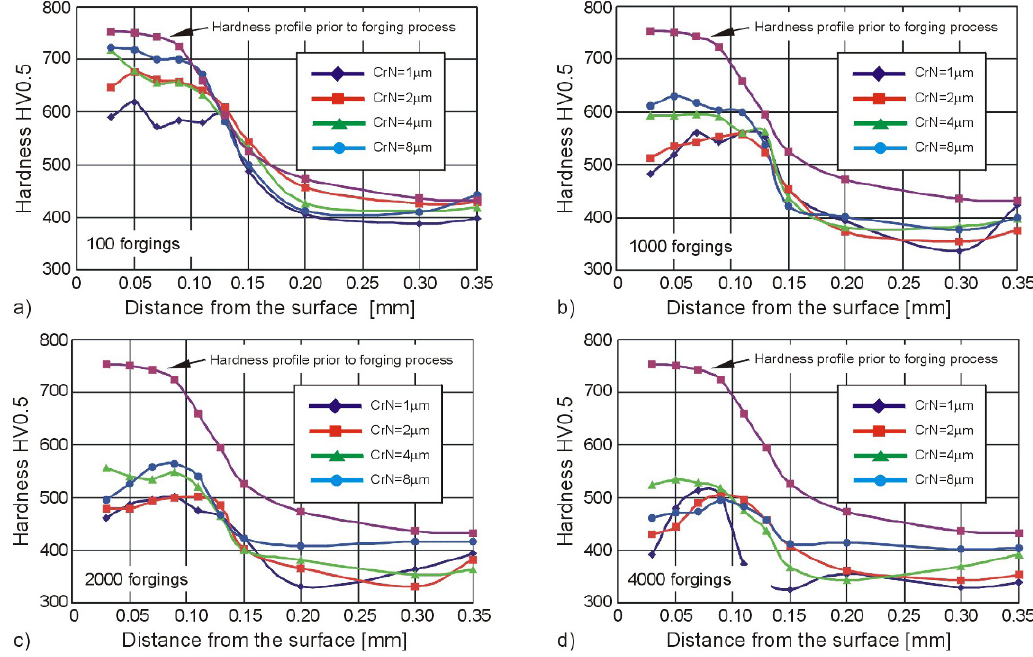
Figure 4. Results of hardness measurements in the distance function from the surface for dies covered with hybrid layer “nitrides layer / CrN” with a different thickness of CrN coating, after their various maintenance time: a) 100 forgings, b) 1000 forgings, c) 2000 forgings, d) 4000